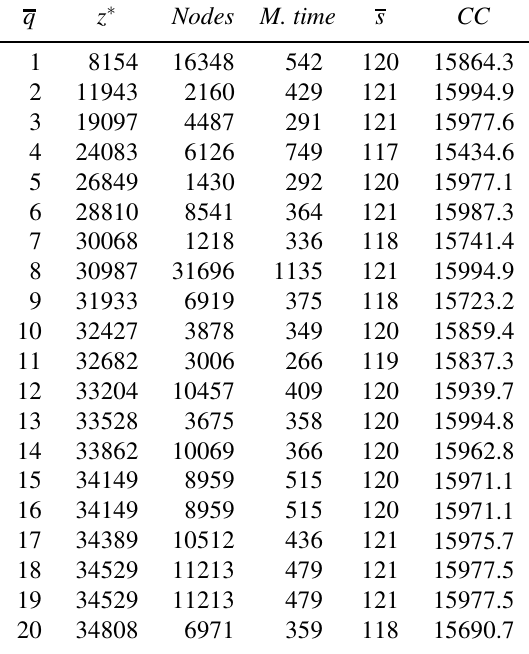
Table 7. Computational results for C 4